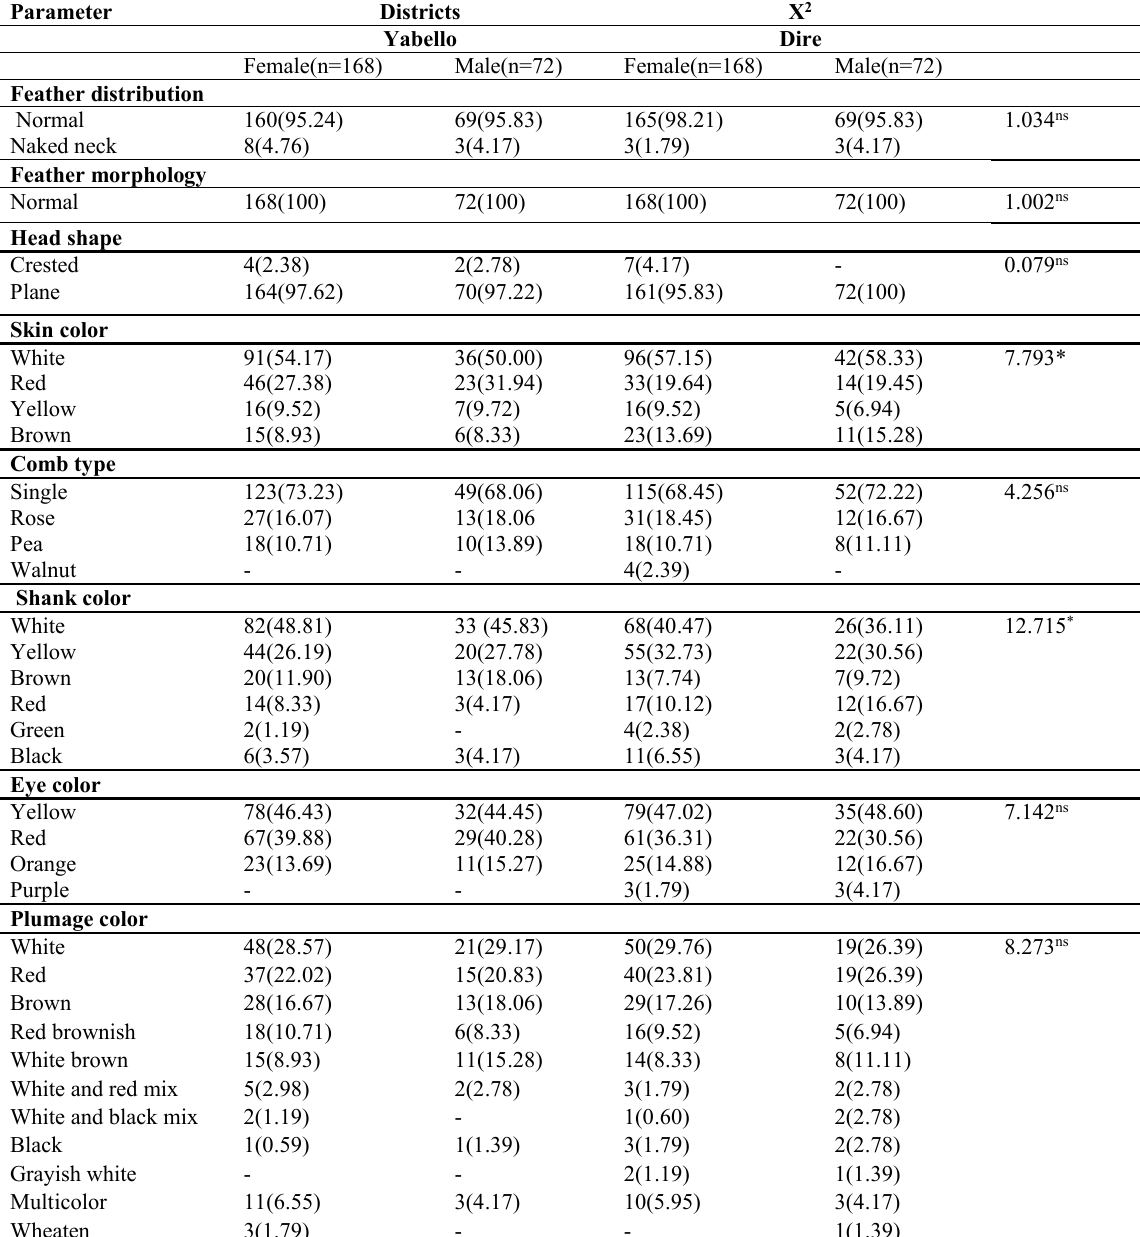
Table 1. Qualitative characteristics of local chicken ecotypes in the study